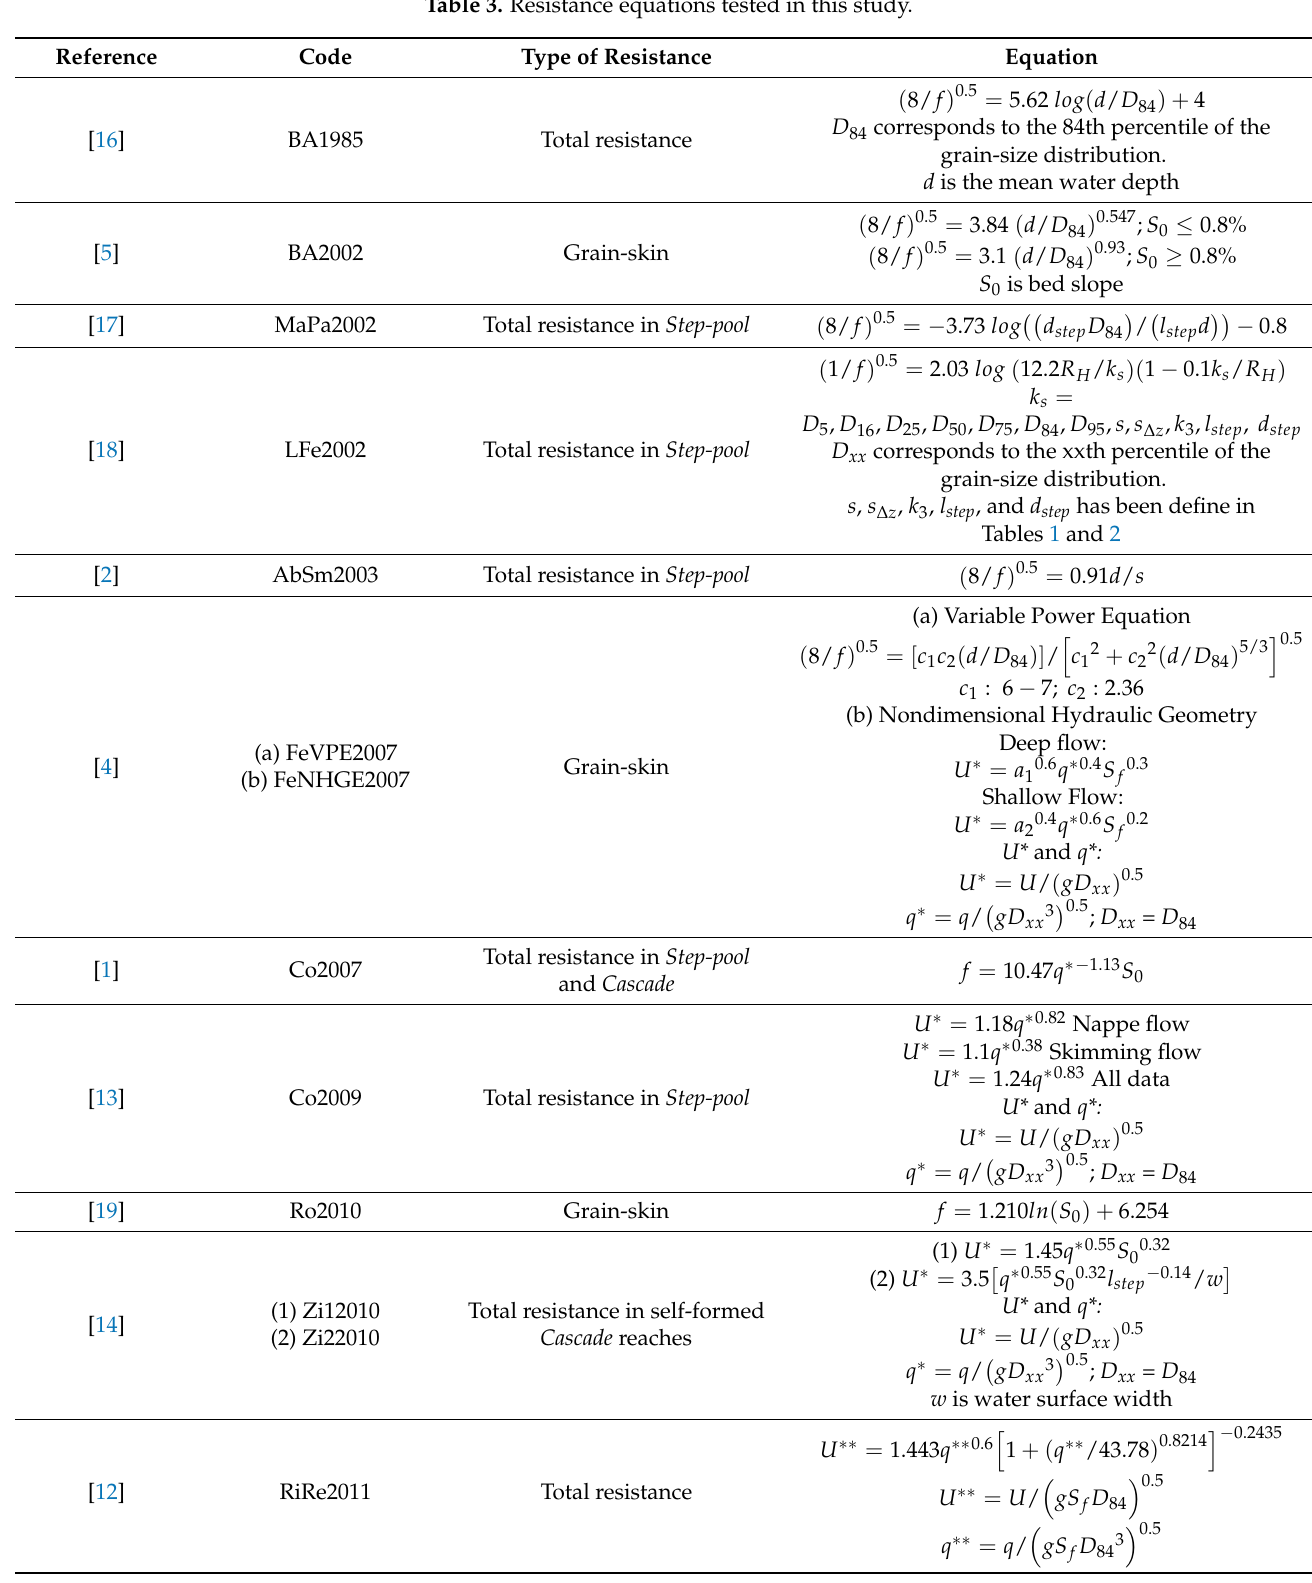
Table 3. Resistance equations tested in this